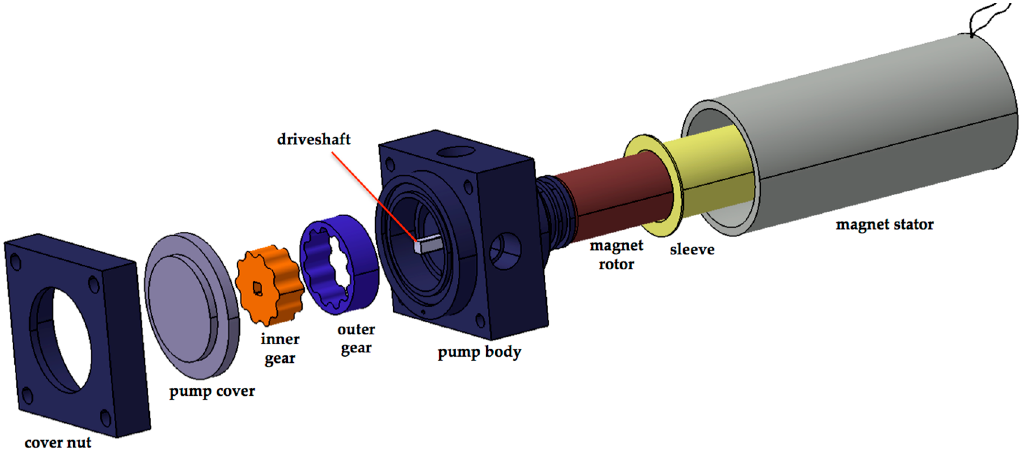
Figure 5. Three-Dimensional (3D)-CAD exploded view of the mini trochoidal-gear pump architecture.